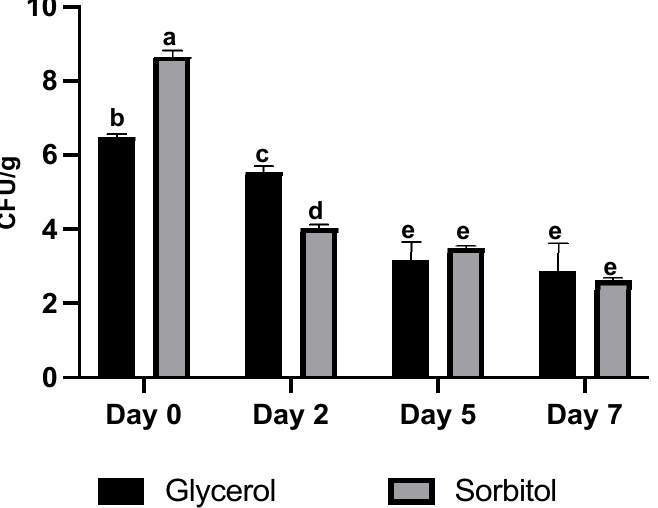
Figure 7. The survival rate of E. faecium in bioactive edible films (formula 5 and formula 6) after refrigeration at 4 ◦ C on days 0, 2, 5 and 7. The different letters represent a significant difference of p < 0.05.